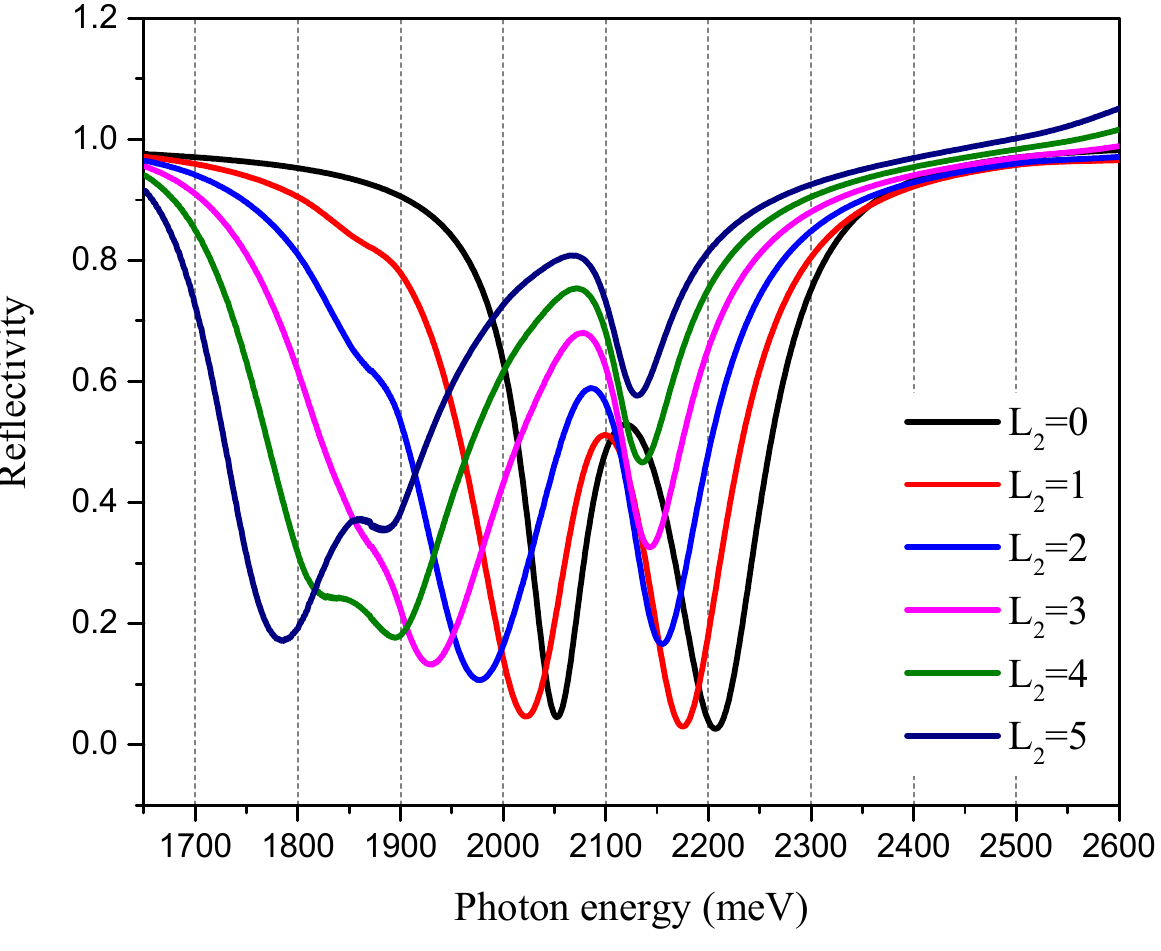
Figure 4. The strong coupling effect between the SPPs and the TDBC exciton regulated by the MoS 2 thickness. The thickness of the Ag film is 42 nm, the incident angle of the excitation light is 49°, and L2 is the number of MoS 2 layers.